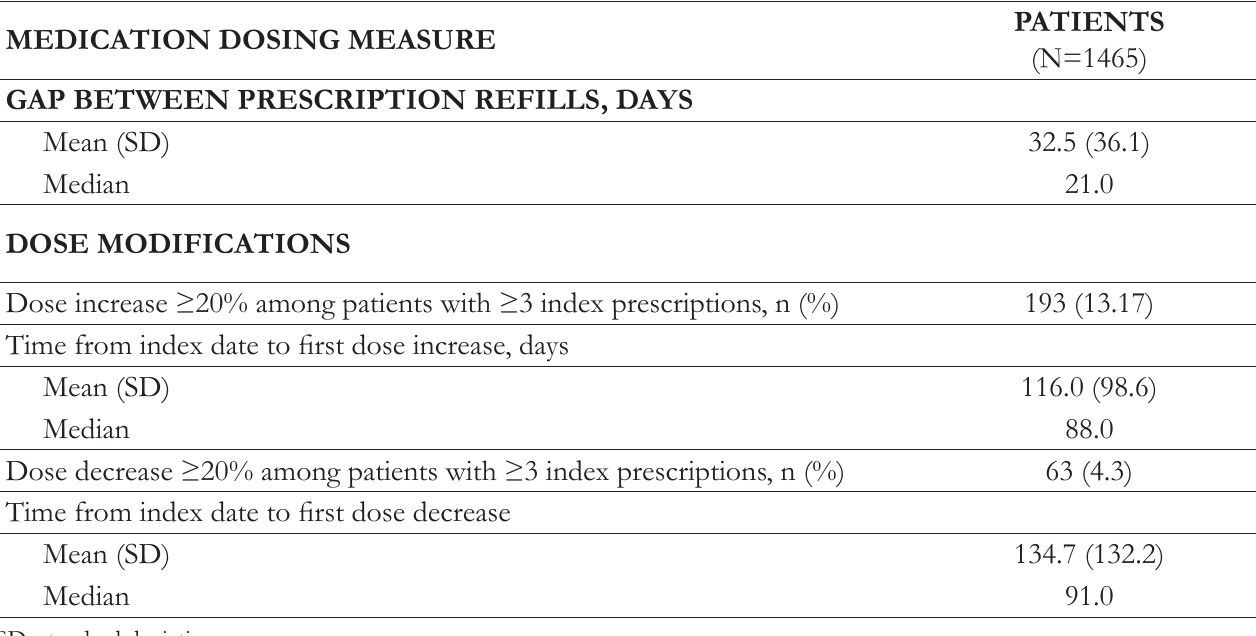
Table 2. Dose and Dose Modifications During Post-index Period